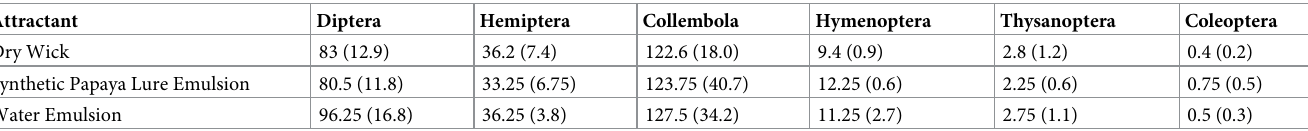
Table 4. The mean number (SE) of insects arthropods found on sticky traps (n = 6) baited with a dry cotton wick (dry wick), a saturated wick with synthetic papaya oil lure in mineral oil emulsion (synthetic papaya lure emulsion) or a wick saturated with mineral oil and water emulsion (water emulsion) collected over 24 h in Miami, Florida, USA. Emulsions were 1:1:0.2 water/oil/ Tween 1 80.